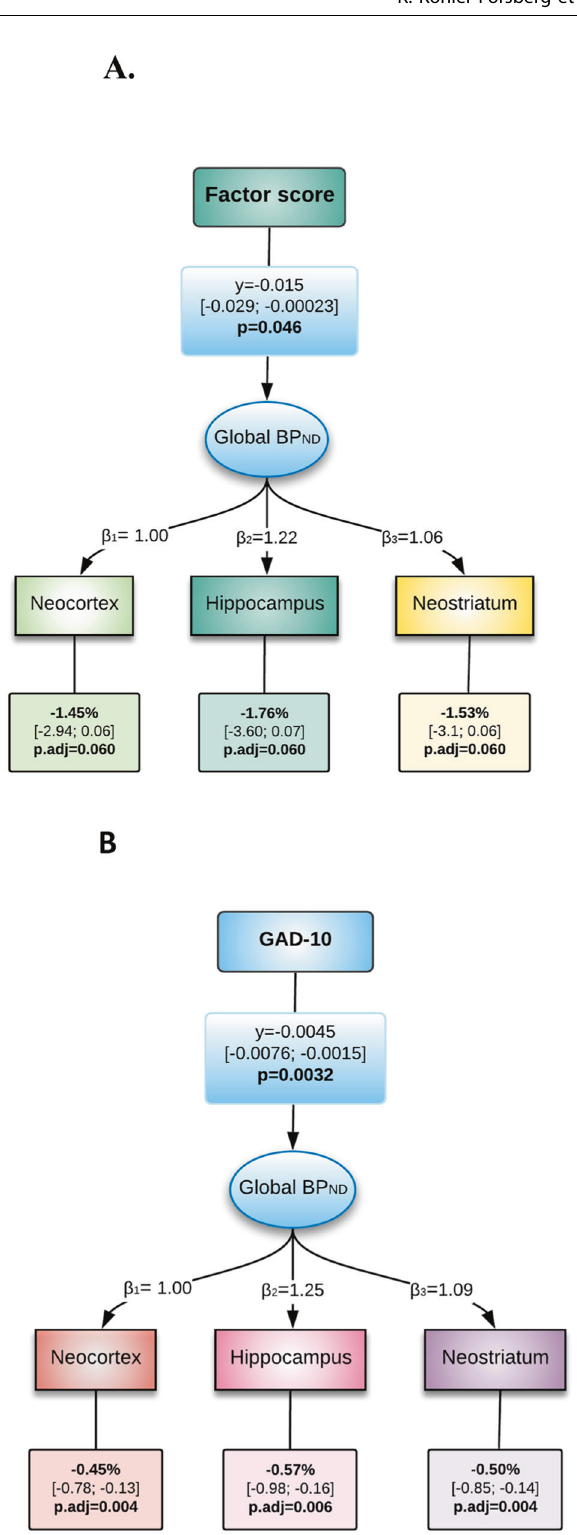
Fig. 1 LVM of Baseline Scores. A Latent variable model of log- transformed baseline 5-HT 4 R BP ND and factor score. B Latent variable model of log-transformed baseline 5-HT 4 R BP ND and GAD-10. Factor score: Anxiety/somatization factor score. GAD-10: Generalized Anxiety Disorder 10 items. The lower boxes contain the percent change in regional binding for each unit increase in factor-score and GAD-10 score. β and γ correspond to the effects on the log- transformed binding.